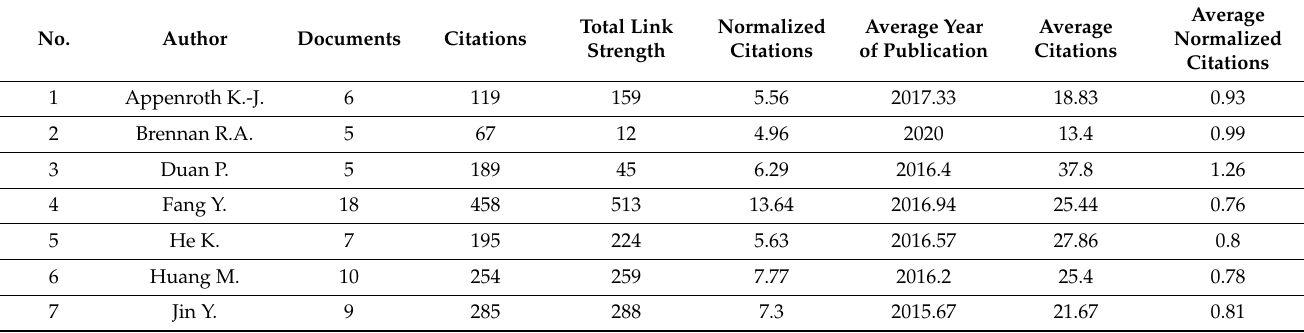
Table 2. Documents with high impacts based on normalized citations.